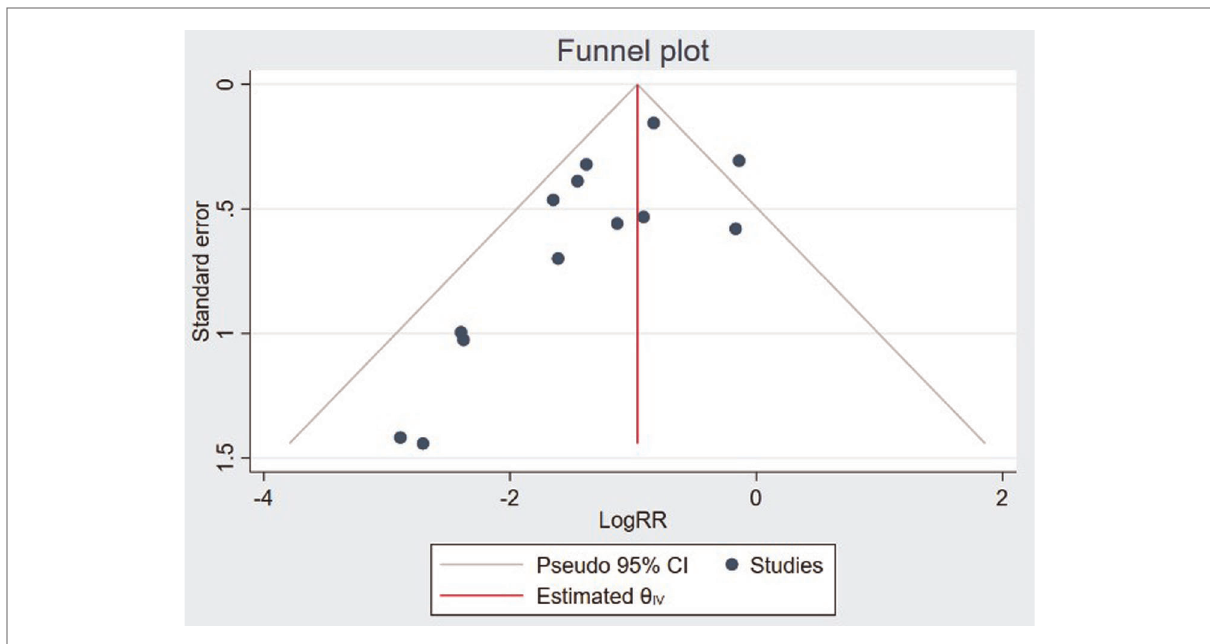
FIGURE 8 Funnel plot for publication